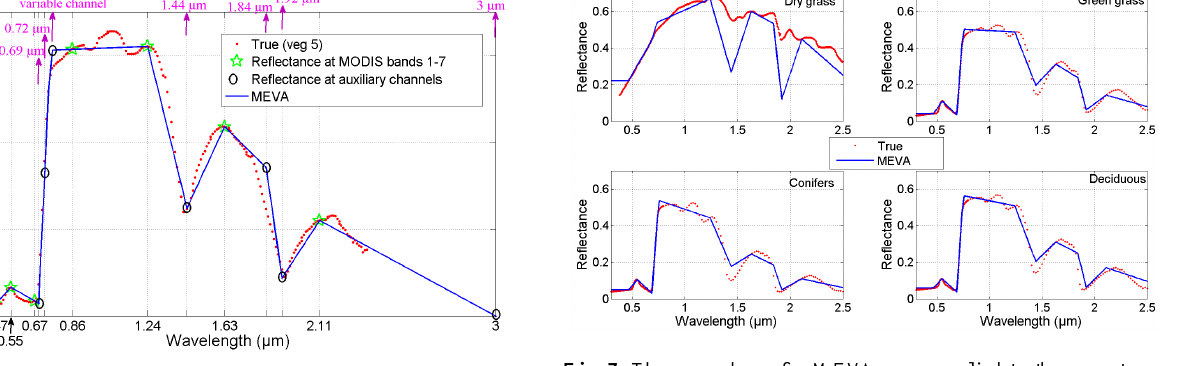
Fig. 6. Processes used to develop MEVA. The x-axis is wavelength (from 0.3 to 3µm) labeled with MODIS bands 1–7 on the bottom and the auxiliary channels (0.69, 0.72, the variable channel end- ing the red edge, 1.44, 1.84, 1.92, and 3µm) at the top. Four of these auxiliary channels were shown in Fig. 5. For the other three auxiliary channels, the variable channel ending the red edge is the crossing point between the linearly extrapolated line from 0.69 to 0.72µm and the linearly extrapolated line from 1.24 to 0.86µm; the auxiliary channel at 1.84 and 3µm are determined by averaging the experimental results of several types of vegetation. The dotted red curve (“true”) represents reflectance spectra as shown in Fig. 2; the green stars present the corresponding reflectance at MODIS bands 1–7; the ovals represent the determined reflectance at aux- iliary channels; the solid blue line represents MEVA. The detailed procedures for MEVA are explained in Sect. 2.2.